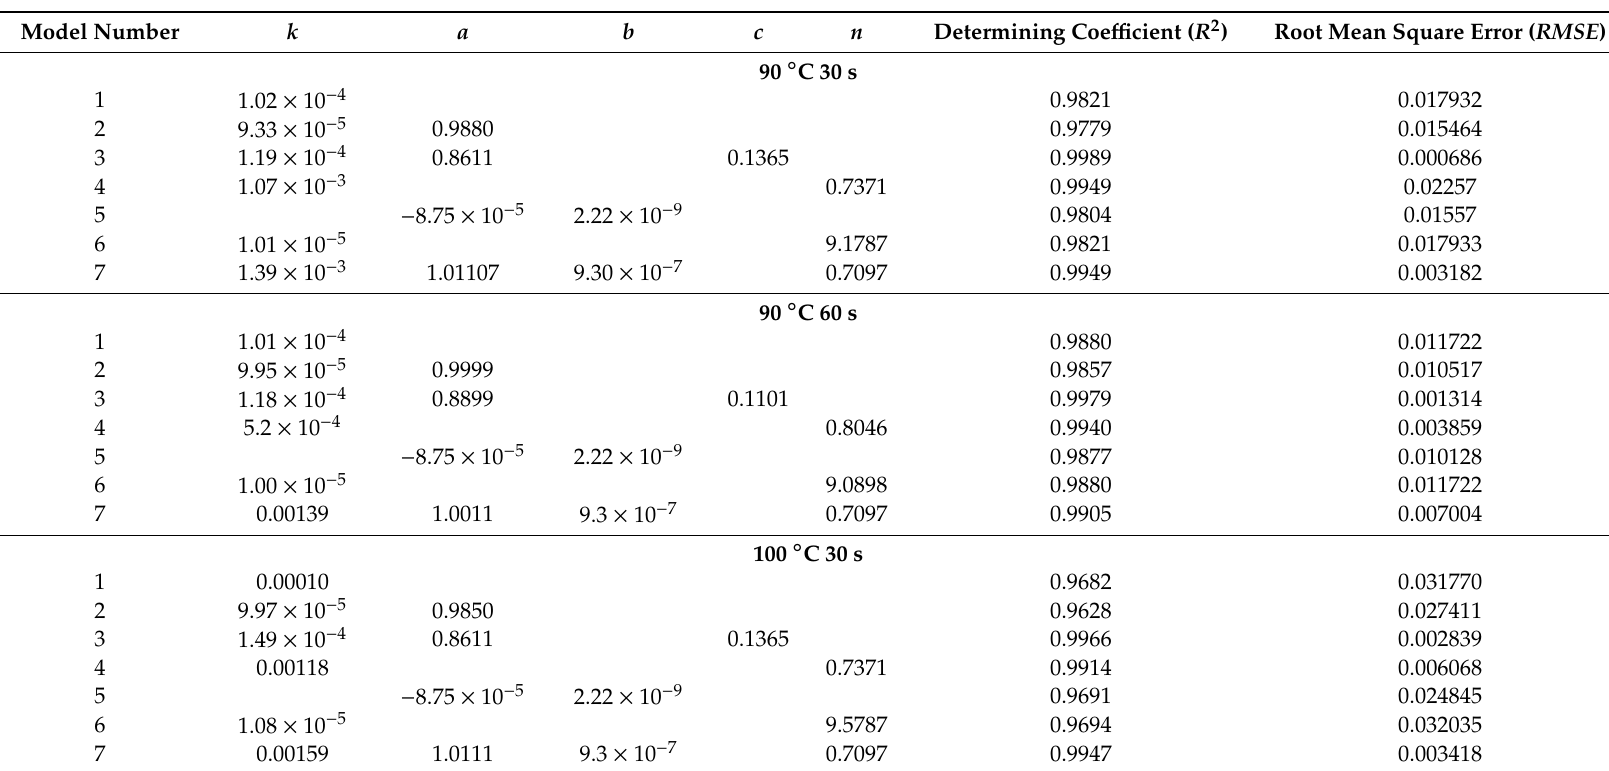
Table 5. Curve fitting criteria for various mathematical models and parameters for blanched and unblanched pomegranate arils cv. Wonderful. Model